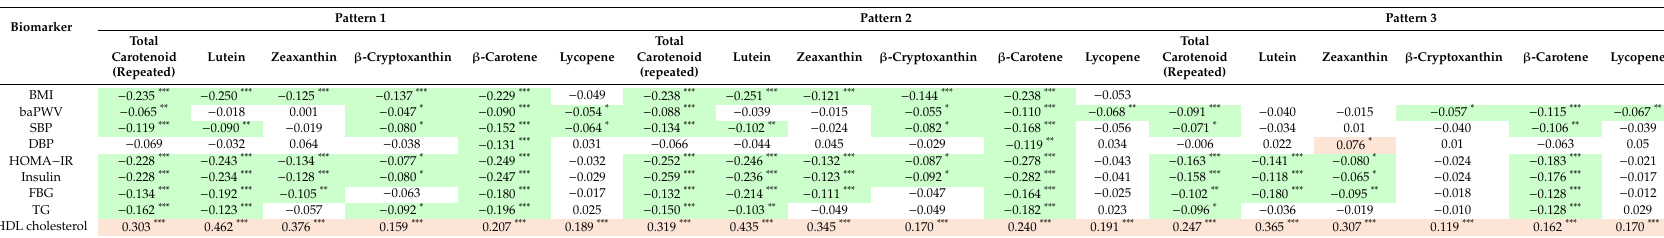
Table 5. Multiple linear regression analysis showing association between cardiovascular disease markers and each carotenoid’s concentration in the blood in females. Biomarker Pattern1 Pattern2 Pattern3 Total